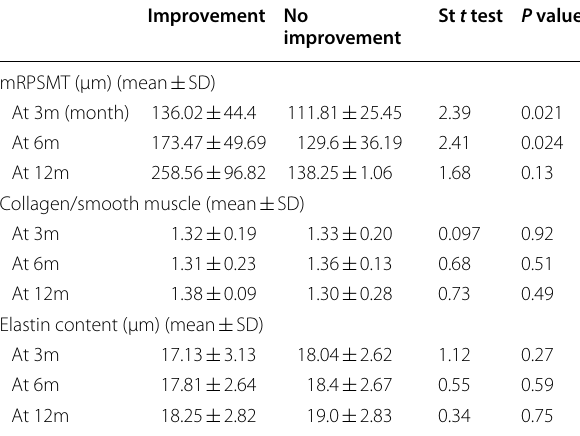
Table 4 mRPSMT, collagen/smooth muscle and elastin after different follow-up